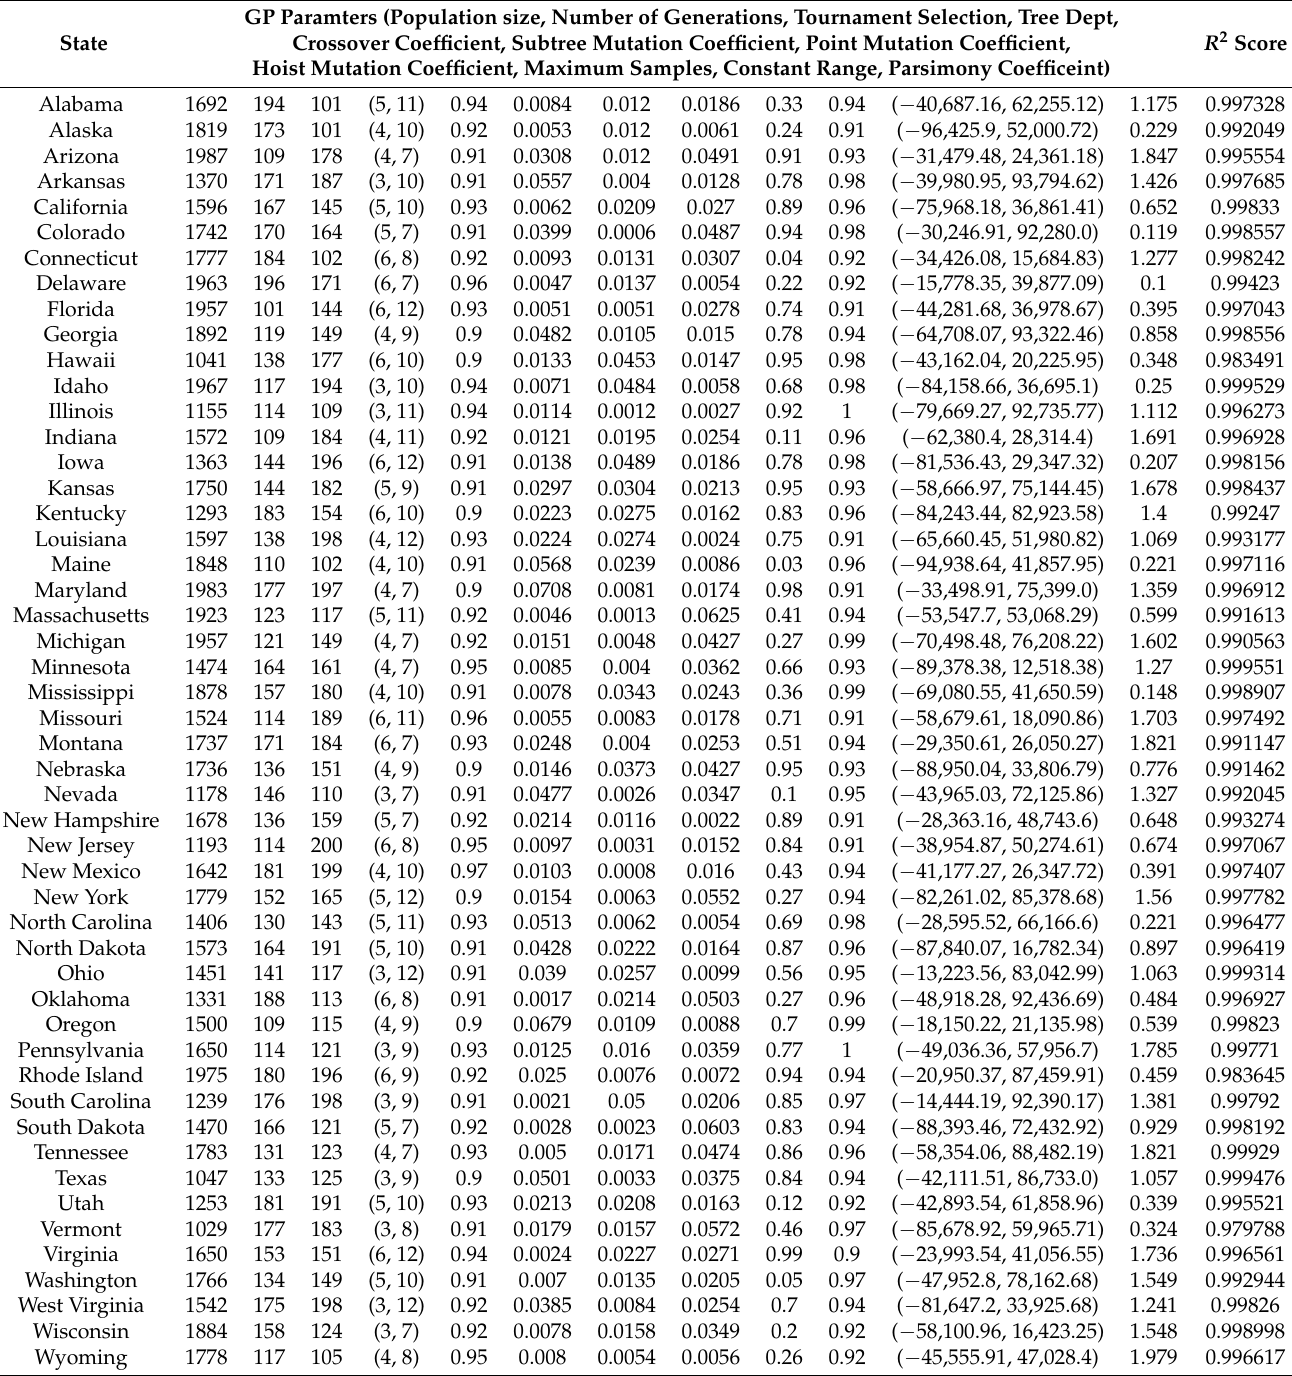
Table A3. TGP parameters used to obtain symbolic expressions of recovered patients for each state with achieved R 2